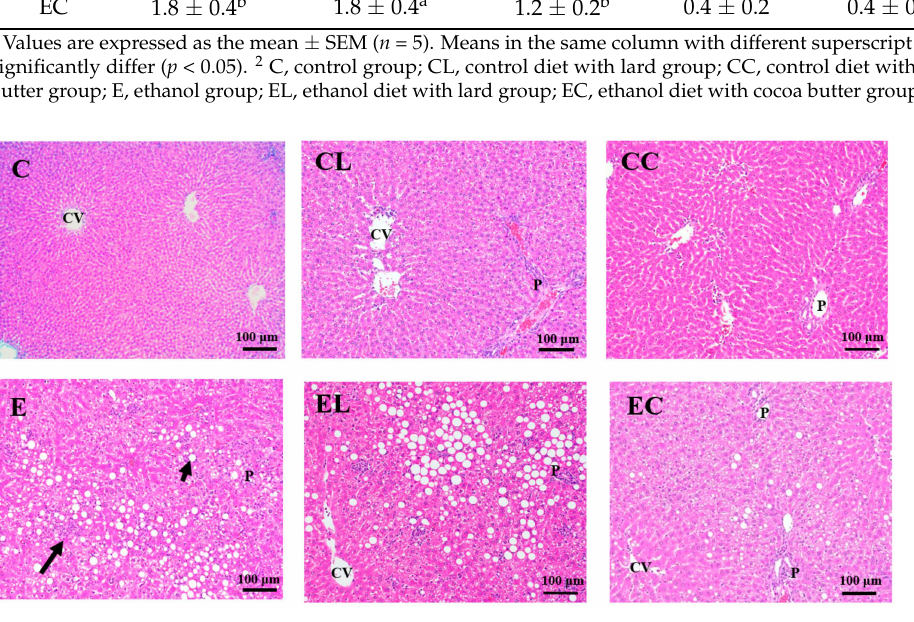
Figure 1. Effects of different dietary fat sources on hematoxylin and eosin (H&E) staining of liver tissue sections in rats. CV, central vein; P, portal area; C, control group; CL, control diet with lard group; CC, control diet with cocoa butter group; E, ethanol group; EL, ethanol diet with lard group; EC, ethanol diet with cocoa butter group. The long arrow shows hepatocyte degeneration and necrosis accompanied by inflammatory cell infiltration. The short arrow indicates lipid